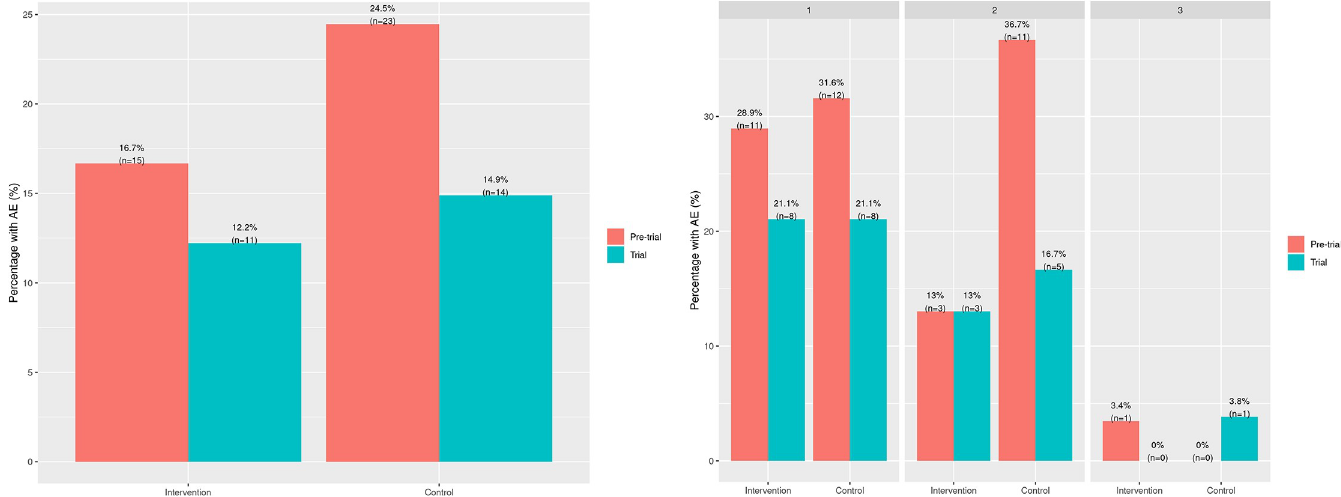
Fig 4. Comparisons of the frequency of asthma exacerbation (the primary endpoint) between the intervention and control group (Fig 4A for overall intervention and control group and Fig 4B for individual strata) during the 12 months prior to the trial and the 12-month trial. A. Comparison between overall intervention and control group. B. Comparison between intervention and control group at pre-trial and trial by stratum.